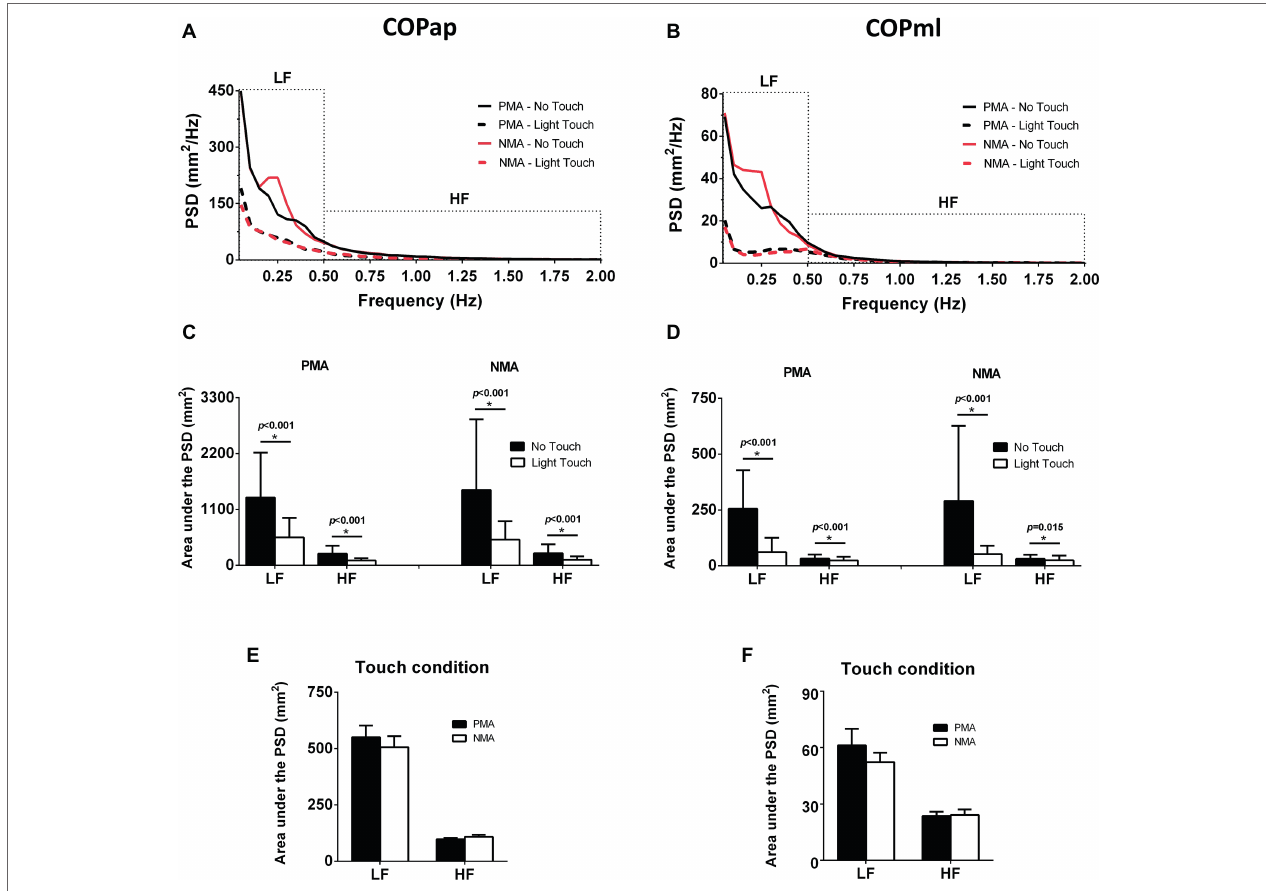
FIGURE 4 | Frequency-domain analyses showing the power spectral densities (PSDs) of the COP signals in different conditions. (A) Mean power spectra ( n = 11) of COPap. (B) Mean power spectra of COPml. (C) Bar plots show the areas under the COPap PSDs divided into low-frequency (LF, 0.05–0.5 Hz) and high- frequency (HF, 0.5–2 Hz) bands. (D) The same as in C, but for COPml. (E) Areas under the PSDs during LT in the PMA and MNA conditions measured from the COPap. (F) The same as in E, but for the COPml. * indicates significant differences ( p <